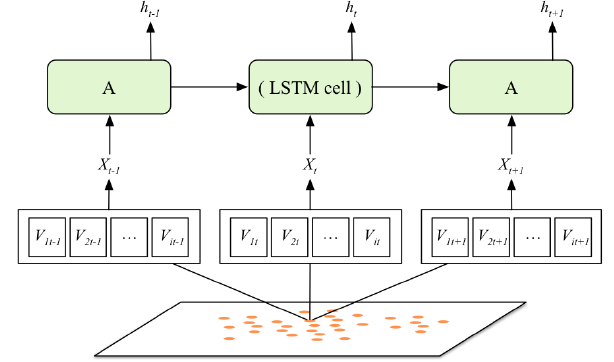
Figure 3. The LSTM model structure of this study. Table 1. Details of the experimental settings.